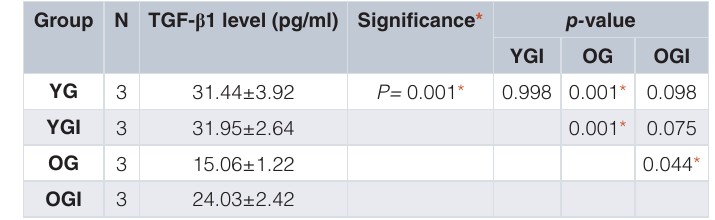
Table 2. Descriptive statistics and results of the Anova and Tukey HSD tests comparing the TGF- β 1 in the 4 groups tested at day 7 after orthodontic appliance